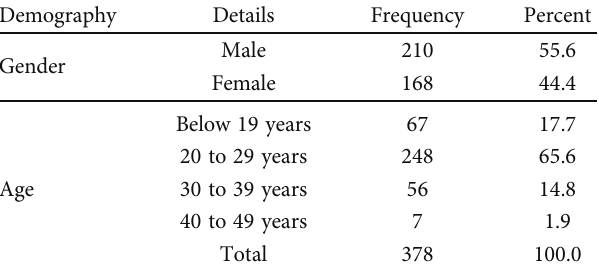
Table 1: Demographic pro fi